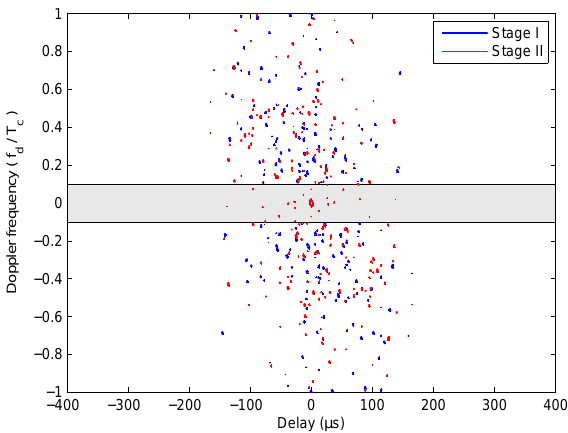
Figure 13. The sidelobes of the optimized LFM-PC waveforms for the one-main-lobe.